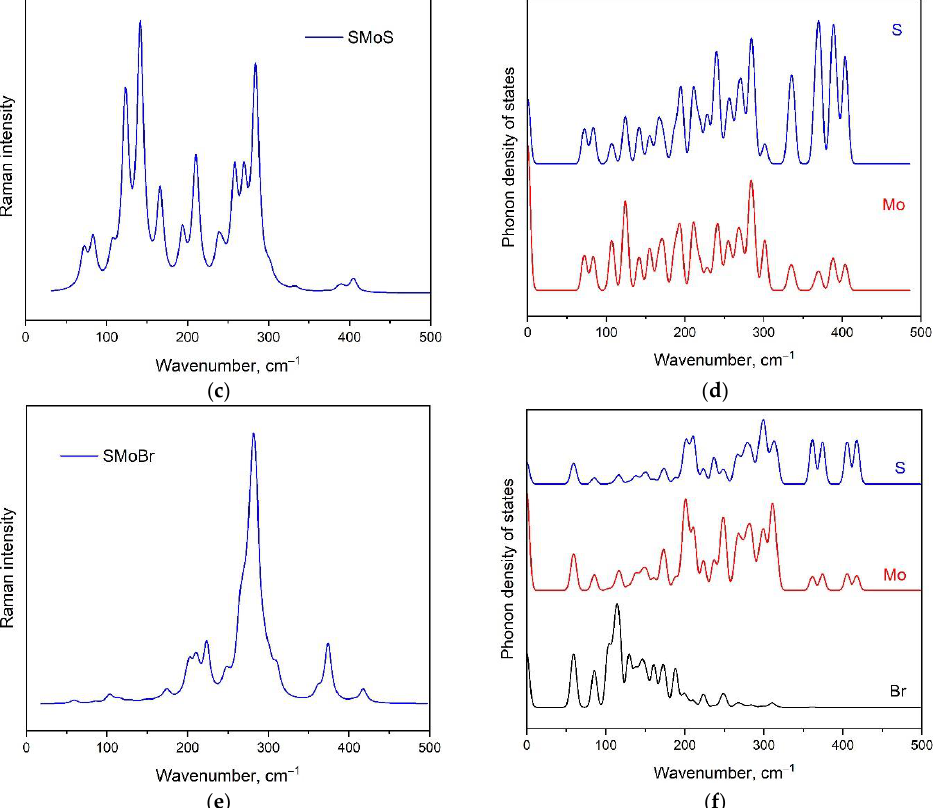
Figure 8. Simulated Raman spectra of the Chevrel phase of ( a ) bulk Mo 6 S 8 (blue) and MoS 2 (black); ( c ) Mo 3 S 4 monolayer; ( e ) S 2 Mo 3 Br 2 monolayer. The corresponding phonon densities of states are shown in ( b , d , f ),